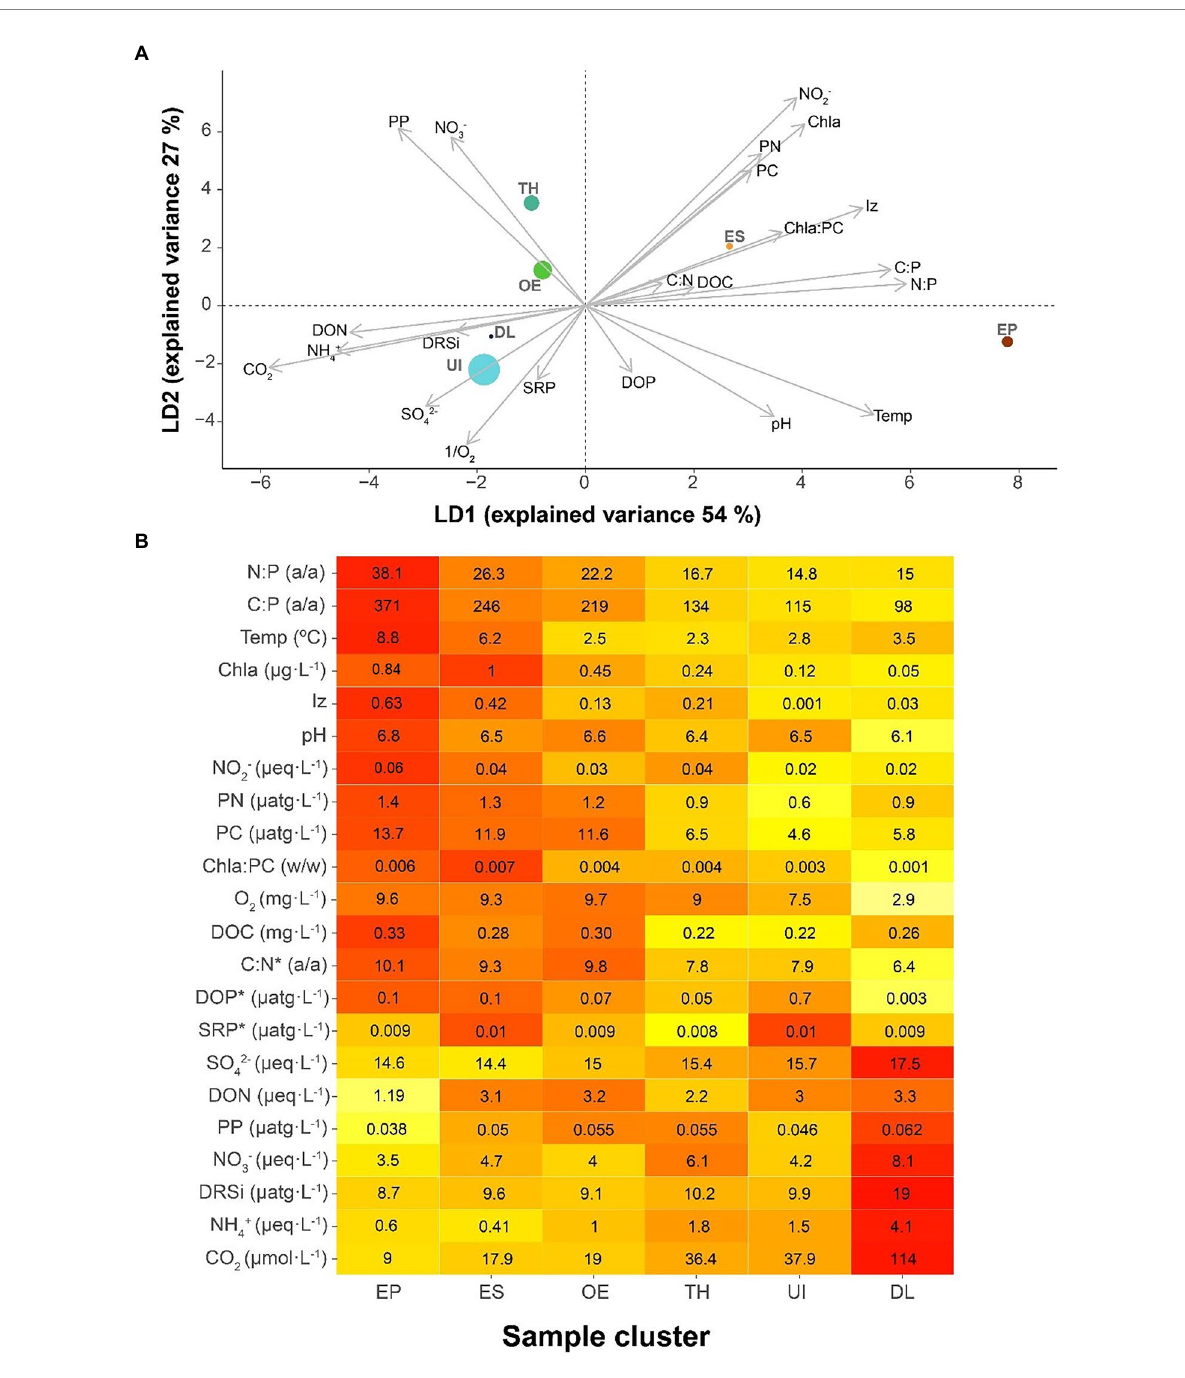
(Supplementary Figure S1). The epilimnetic clusters (ES and EP) showed lower diversity per sample, with median